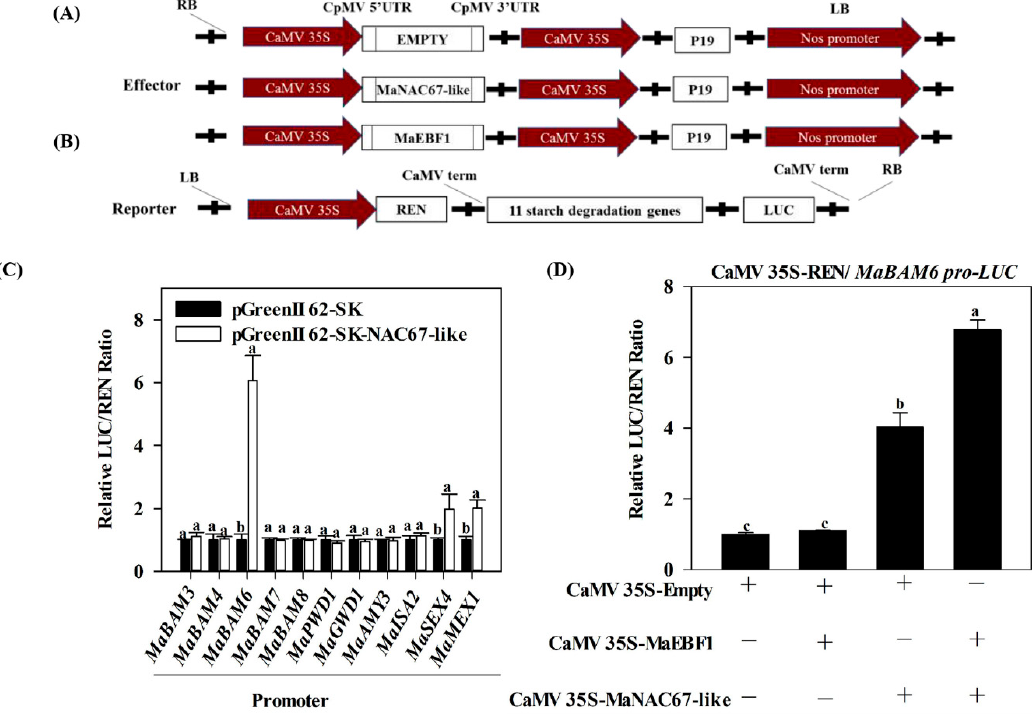
Figure 5. Transcriptional activation of starch degradation genes by MaEBF1 and MaNAC67-like in the transient expression system. The promoters of MaBAM6, MaMEX1, and MaSEX4 were ligated into a pGreenII 0800-LUC double-reporter vector ( A ), while MaNAC67-like was ligated into the pGreenII 62-SK vector as an effector ( B ). The transcriptional activity of MaNAC67-like on the starch degradation-related gene promoter of MaBAM3 , MaBAM4 , MaBAM6 , MaBAM7 , MaBAM8 , MaPWD1 , MaGWD1 , MaAMY3 , MaISA2 , MaSEX4, and MaMEX1 ( C ). The ratio of LUC to REN of the empty vector plus promoter vector was used as a calibrator (set as 1). ( D – F ) Transcriptional activity of MaEBF1, MaNAC67-like, and MaNAC67-like + MaEBF1 on the activities of promoter of MaBAM6 ( D ), MaMEX1 ( E ), and MaSEX4 ( F ). Each value was calculated from the means of six biological replicates. The values represent the means ± SE.